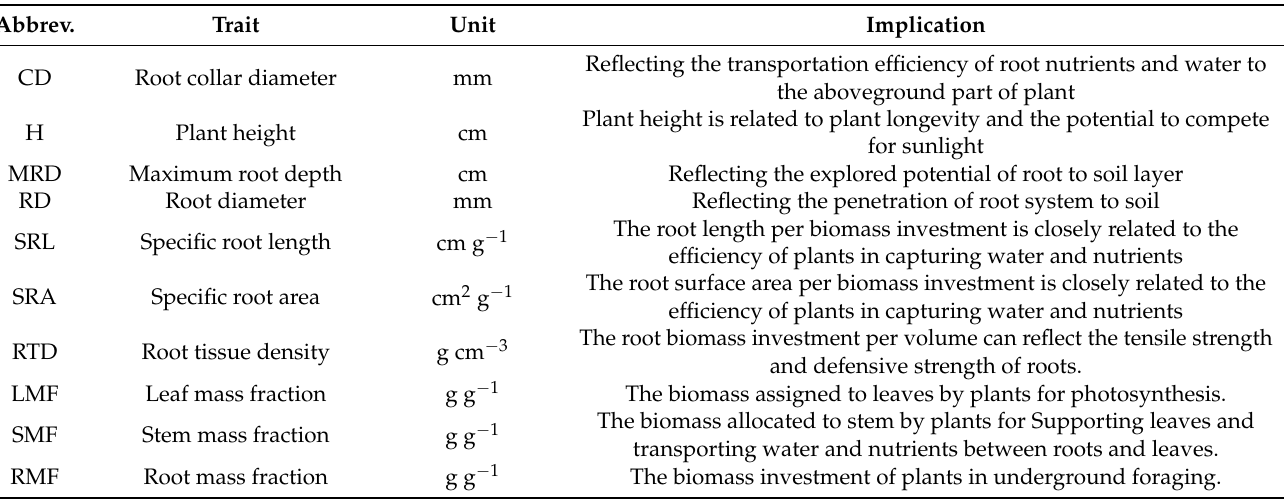
Table 3. Description of morphological traits measured on ephemeral species rooting in loose sand or gravelly or dense sand in the cold desert of the Chinese Junggar Basin in